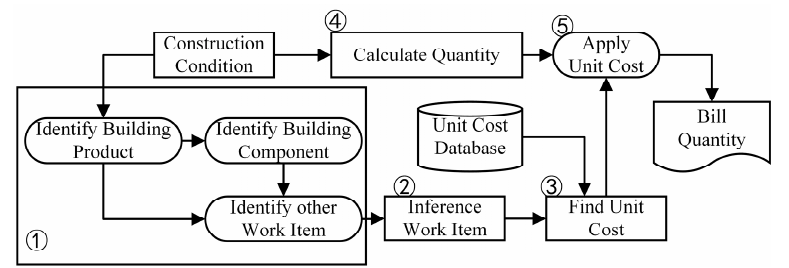
Figure 16. Process of cost estimation.